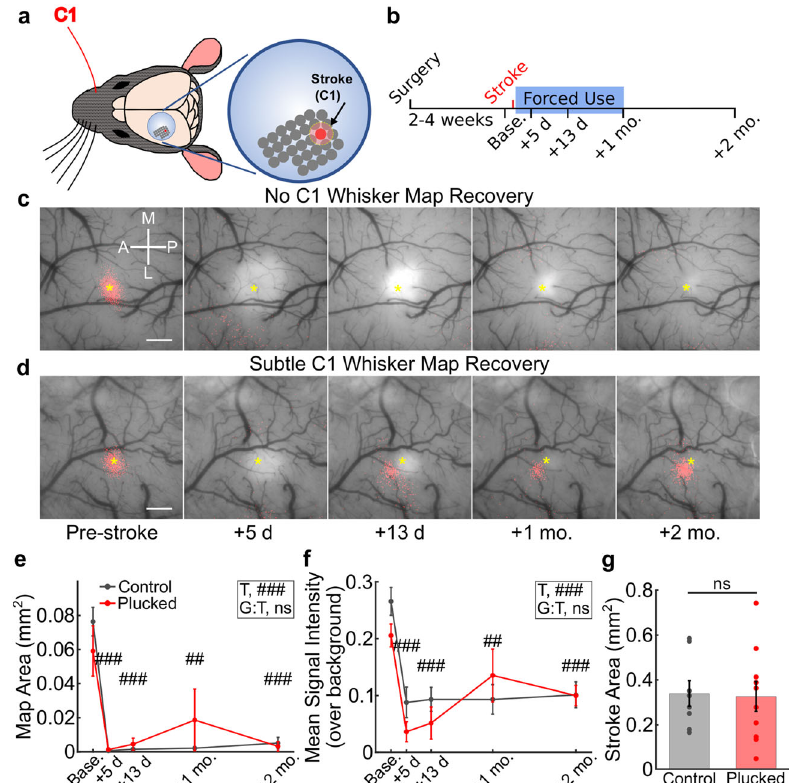
Fig. 4 Forced use therapy does not trigger macroscopic remapping after C1-targeted stroke. a Schematic of forced use rehabilitation paradigm, where all right-sided whiskers are plucked except C1. b Timeline of surgery, imaging, and forced use whisker plucking. c , d ISI map of C1 whisker-evoked activity before and after stroke overlaid on photographs of the cranial window in representative mice (with strokes in C1 barrel) that exhibited no recovery of the C1 whisker map ( c ) or subtle partial map recovery ( d ) over 2 months. Scale bar = 0.5 mm. e Quanti fi cation of C1 whisker-evoked ISI map area size throughout recovery in control (gray, n = 8) vs. forced use whisker-plucked (red, n = 10) animals. Two-way repeated measures ANOVA, main effects of timepoint (T, ### p < 0.001) and group-by-timepoint interaction (G:T, p = 0.667). Signi fi cance for individual timepoints compared to baseline, corrected for multiple comparisons using the Tukey-Kramer procedure, indicated over corresponding data points (## p < 0.01; ### p < 0.001). Data in e and f represent mean ± s. e.m. f Quanti fi cation of C1 whisker-evoked ISI signals over background throughout recovery in control (gray, n = 8) vs. forced use whisker-plucked (red, n = 10) animals. Two-way repeated measures ANOVA, main effects of timepoint (T, ### p < 0.001) and group-by-timepoint interaction (G:T, p = 0.213). Signi fi cance for individual timepoints compared to baseline, corrected for multiple comparisons using the Tukey-Kramer procedure, indicated over corresponding data points (## p < 0.01; ### p < 0.001). g Quanti fi cation of stroke size at day 5 after stroke from vasculature images in control (gray, n = 8) and forced use whisker-plucked (red, n = 10) mice. Two-sample, two-tailed t test, p = 0.888. Data represent mean ± s.e.m., with individual dots for each mouse